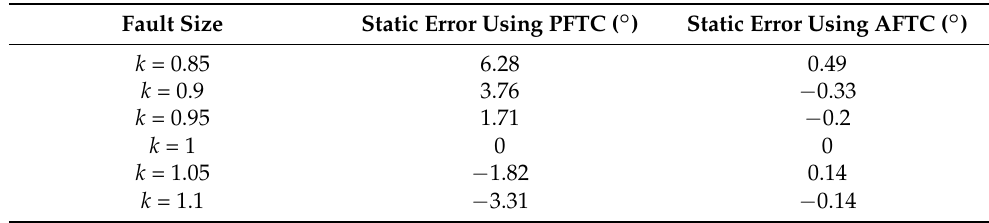
Figure 12. ( a ) Comparison of PFTC and AFTC under the gain variation faults; ( b ) comparison of PFTC and AFTC under the stuck fault. Table 3. Comparison of the control effects of PFTC and